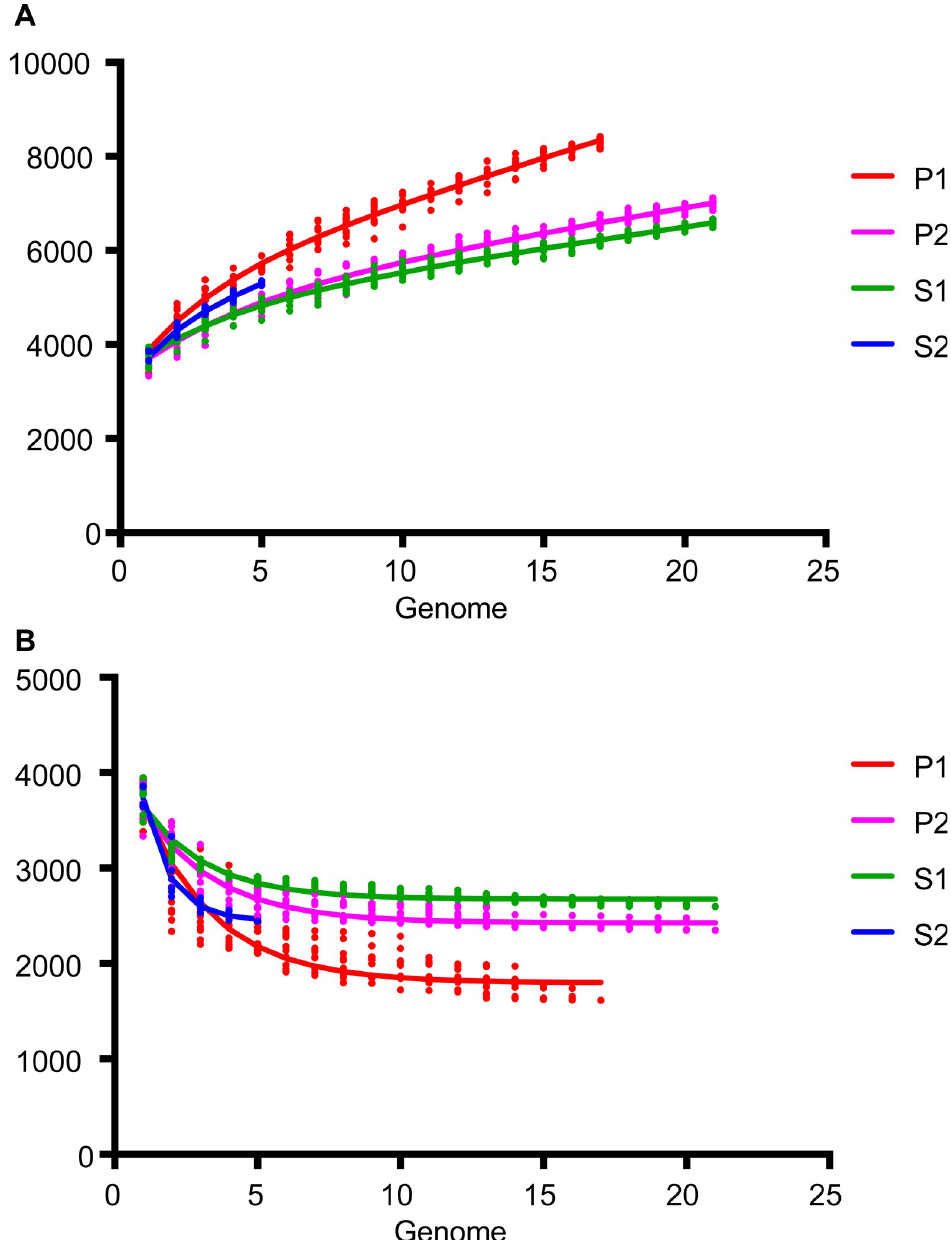
Fig 2. Evolution of (A) pan-genome and (B) core-genome for the genomes of the four leptospiral subclades. Analyses done with GET_HOMOLOGUES (using 17 genomes for P1, 21 for P2, 21 for S1 and 5 for S2) highlighting that the P1 group has a more open